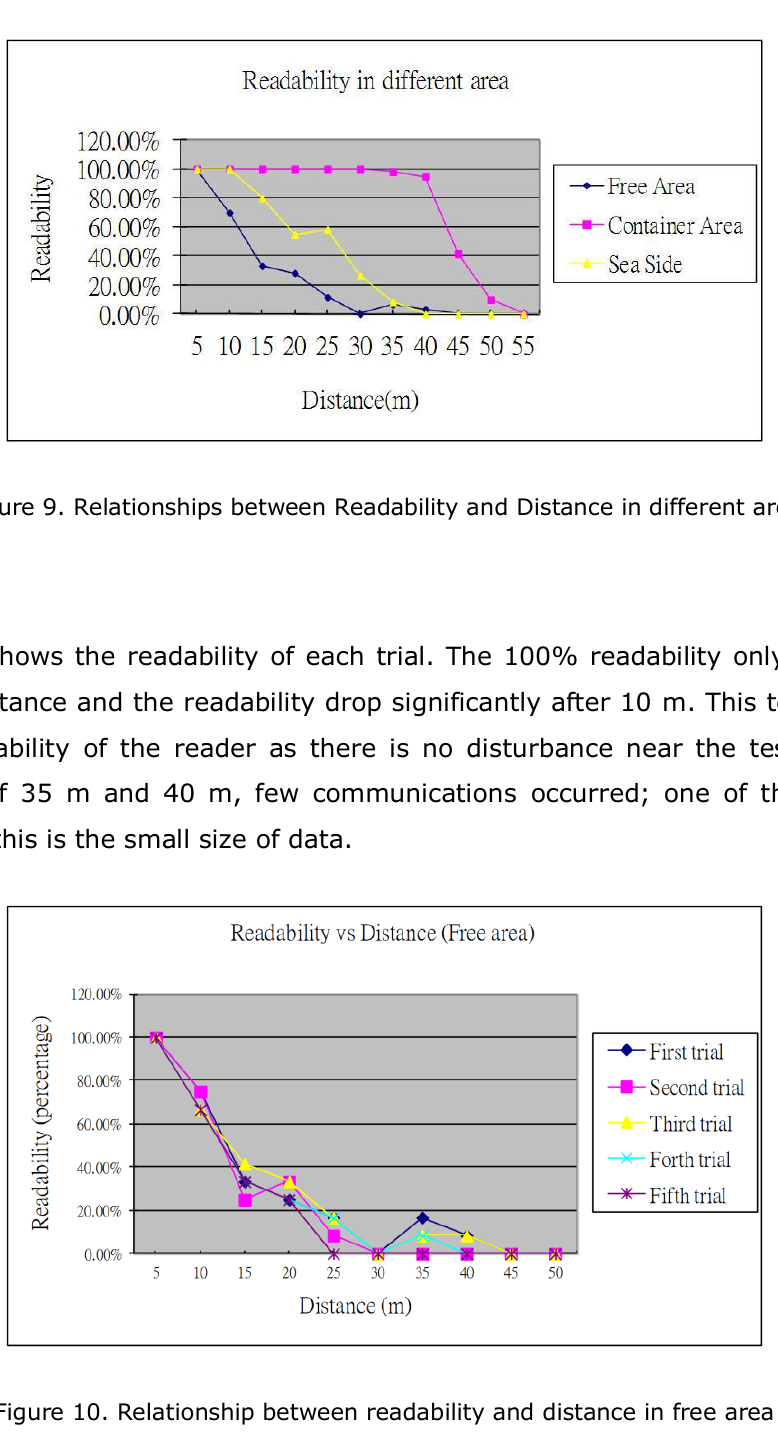
Figure 10. Relationship between readability and distance in free